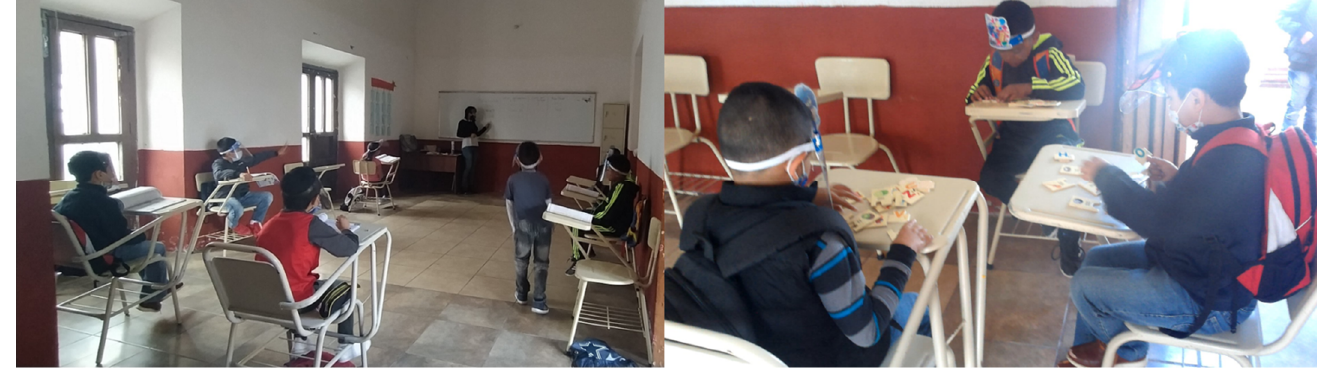
Figure A5. User task design related to the virtual environment Attention-VR.